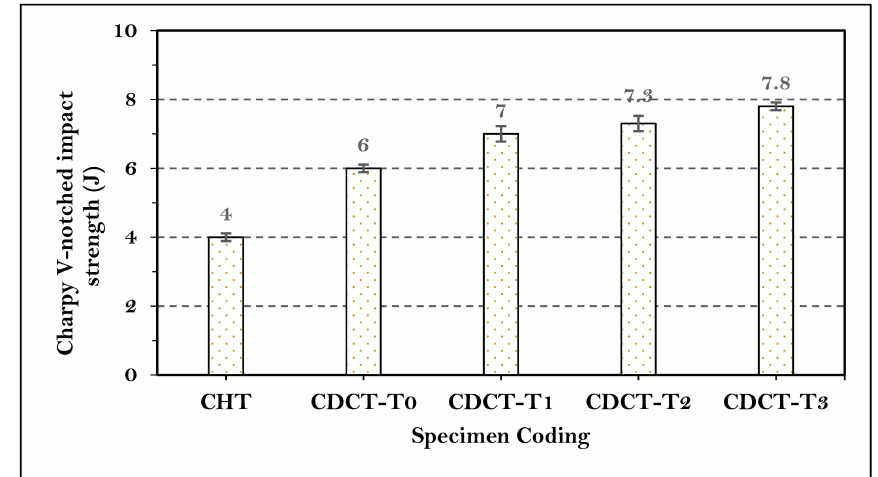
Figure 8. Charpy V-notch impact strength results of treated material.